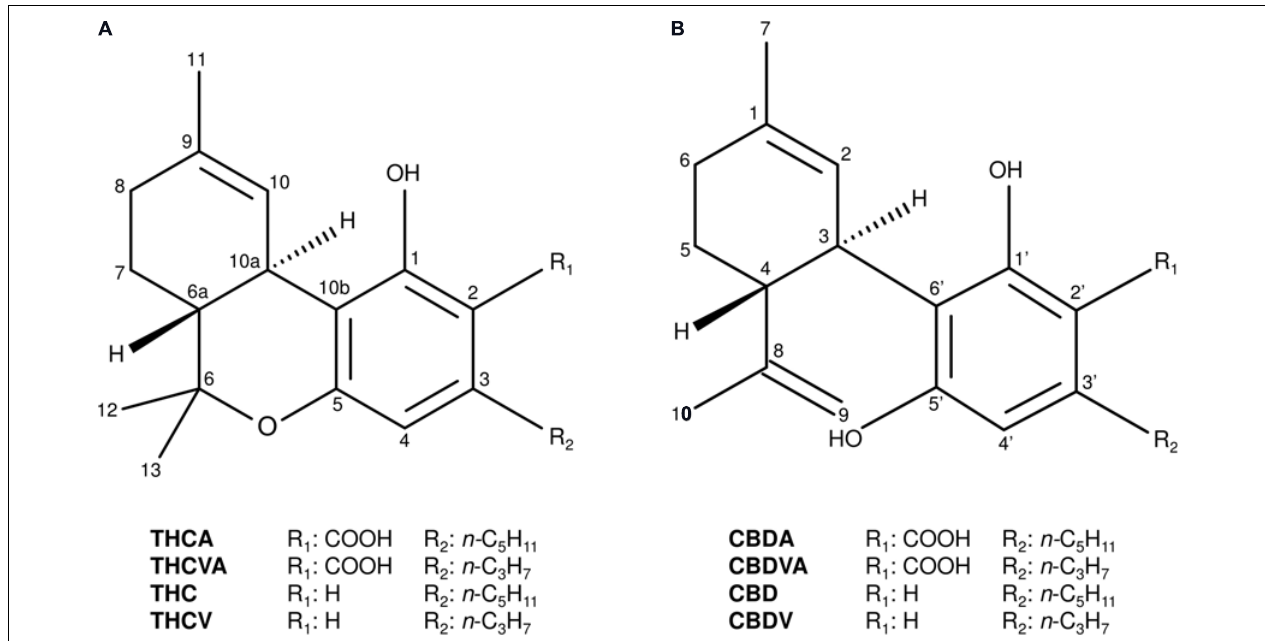
FIGURE 1 | Chemical structures of the major tricyclic and dicyclic alkyl cannabinoids in Cannabis . (A) Tricyclic cannabinoids. (B) Dicyclic cannabinoids. Cannabidiol (CBD); cannabidiolic acid (CBDA); cannabidivarin (CBDV); cannabidivarinic acid (CBDVA); delta(9)-tetrahydrocannabinol (THC); delta(9)-tetrahydrocannabinolic acid (THCA); delta(9)-tetrahydrocannabivarin (THCV); and delta(9)-tetrahydrocannabivarinic acid